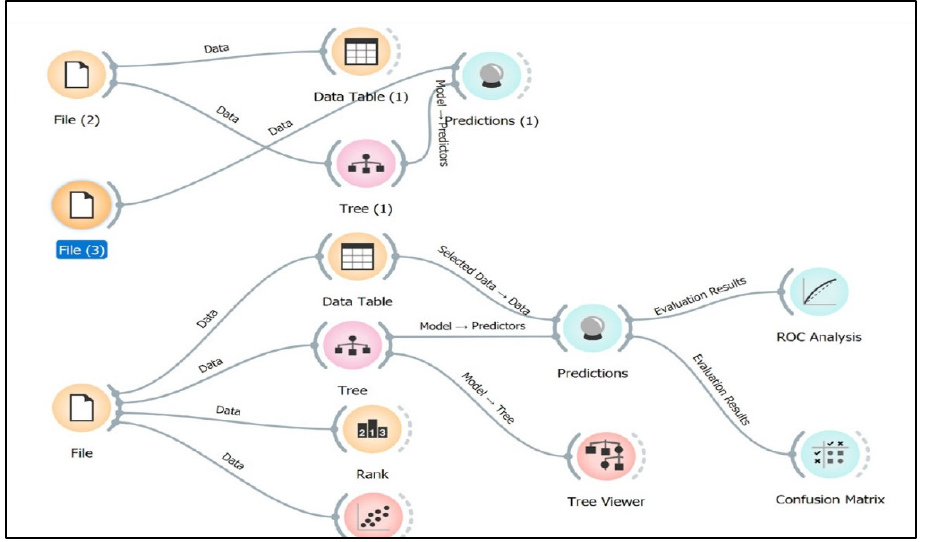
Fig. 1. Image Data Mining to Determine Factors of Tourist